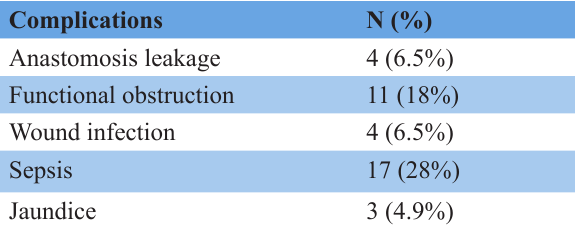
Figure 2. Barium follow through of baby showing jejunal obstruction